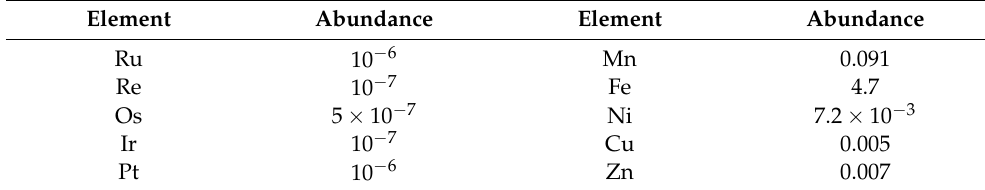
Table 2. Earth abundance (in mass percent) of the metal elements mentioned in this review [62]. Adapted with permission from J. Am. Chem. Soc. 2018, 140, 42, 13522–13533. Copyright 2018 American Chemical